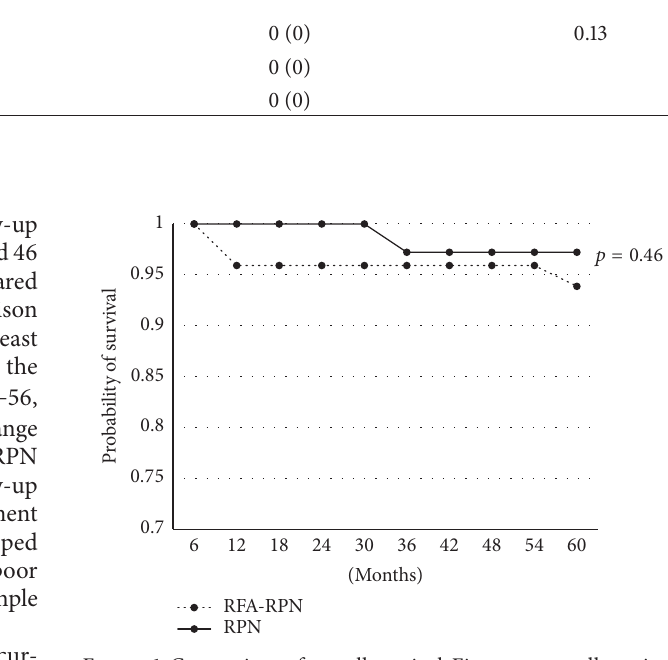
Figure 1: Comparison of overall survival. Five-year overall survivals were compared between the RFA-RPN and RPN